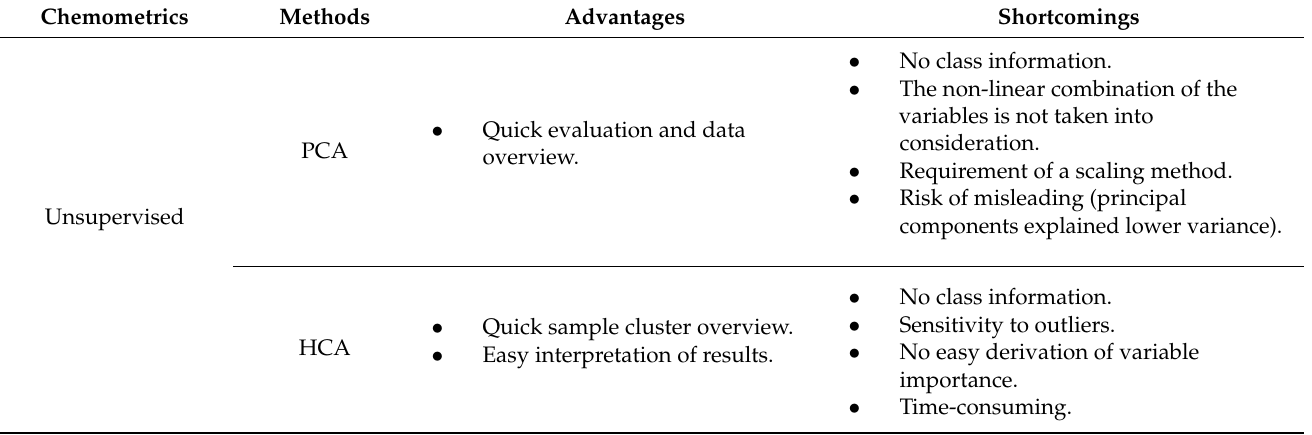
Figure 4. Chemometric analyses associated with nuclear magnetic resonance (NMR) and mass spectrometry (MS) techniques in selected published papers reported according to the frequency of their specific use ( a ) and their first appearance in the literature reviewed here ( b ). Table 6. Summary of the most important advantages and shortcomings of chemometric methods [159,160] related to the works considered in the present review.